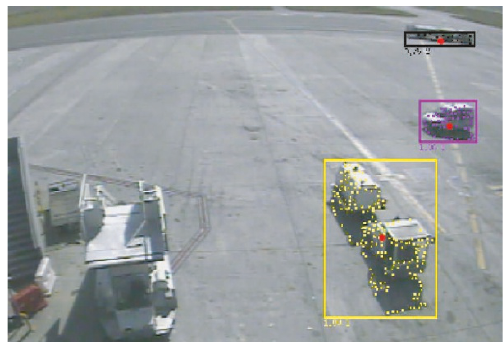
Figure 9: Detected object locations (red circles) shown for 3 vehi- cles in the near-, mid-, and far-field of Camera 5 for sequence